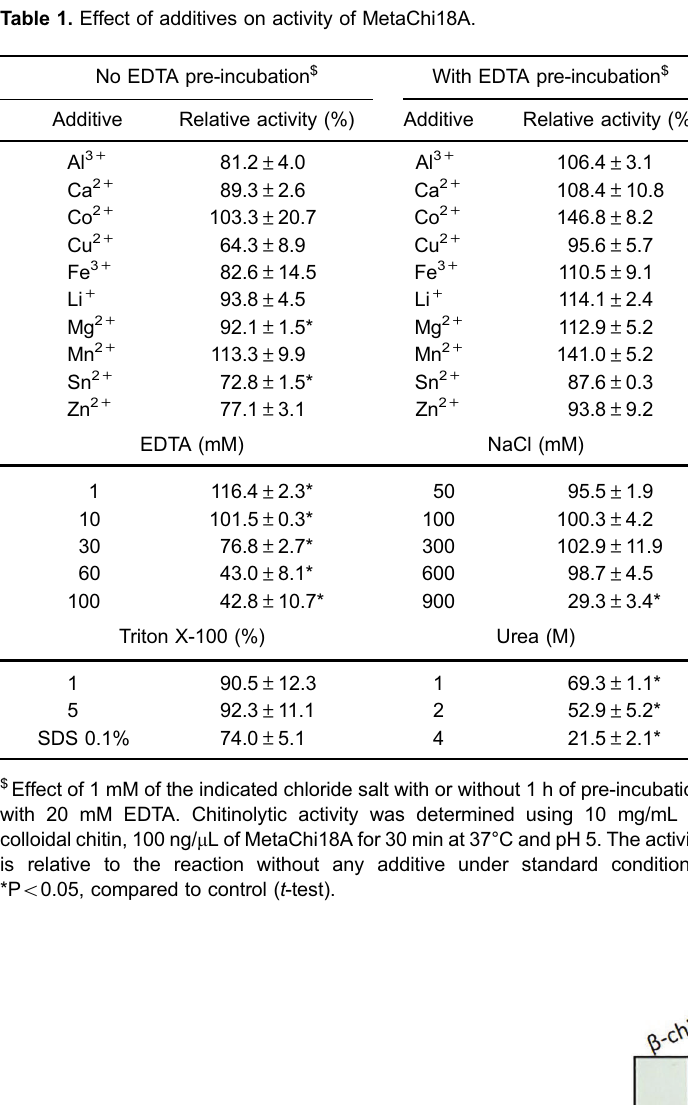
Braz J Med Biol Res | doi: